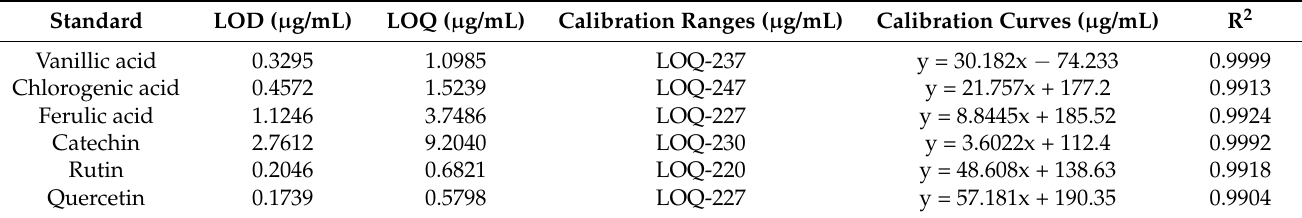
Table 2. Standard analytes used for elaborating the calibration curves with the range used, equations, R 2 , LOD, and LOQ of each compound for the phenolic compounds